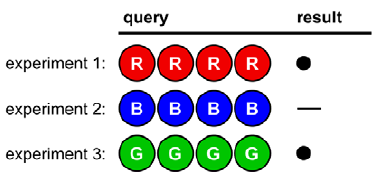
Figure 8. Opening strategy C, illustrating Lesson